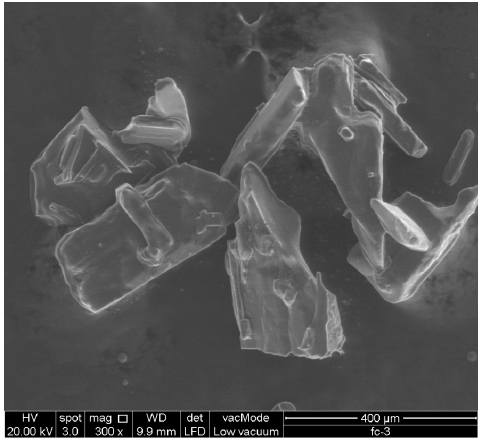
Figure 3. Scanning electron microscopy (SEM) image of pristine ADN used in these experiments.